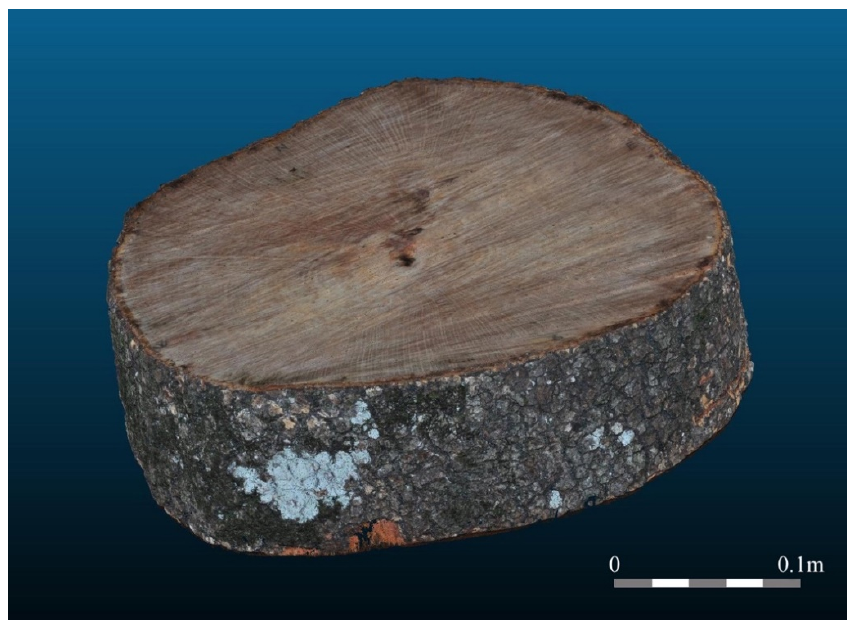
Figure 4. Three-dimensional photogrammetric model of a healthy holm oak sample.